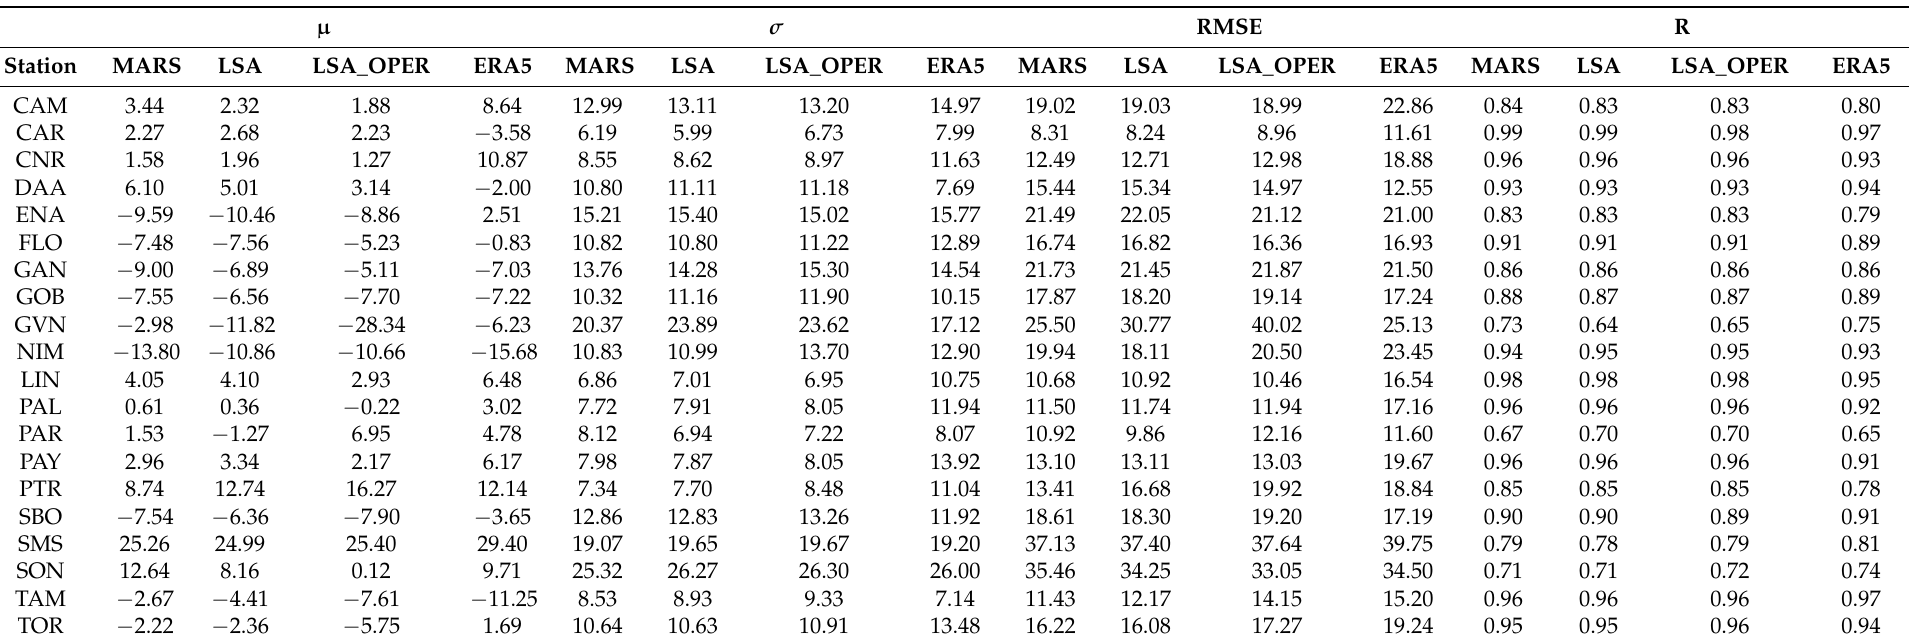
Table A7. Error metrics between model (MARS, LSA_OPER, LSA, and ERA5) and measuring station (cloudy-sky conditions) for 2004–2019. Bias ( µ ),